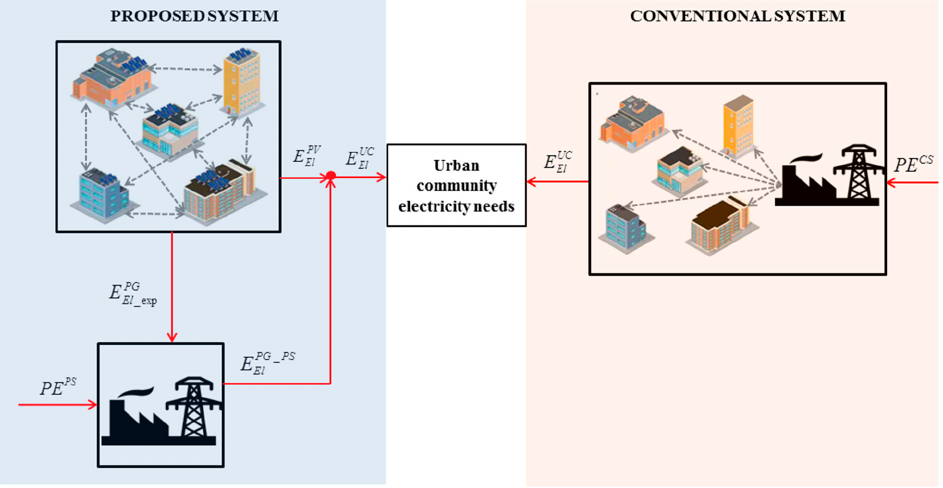
Figure 2. Schematic diagrams of the proposed and conventional systems.